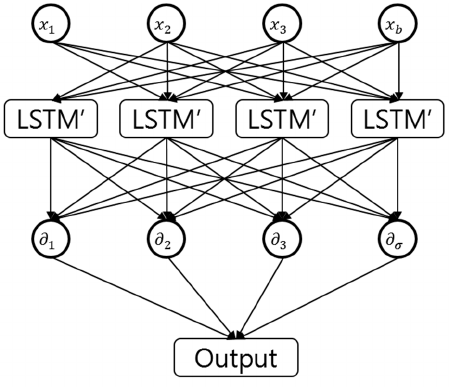
Figure 26. Structure of LSTM + CNN.